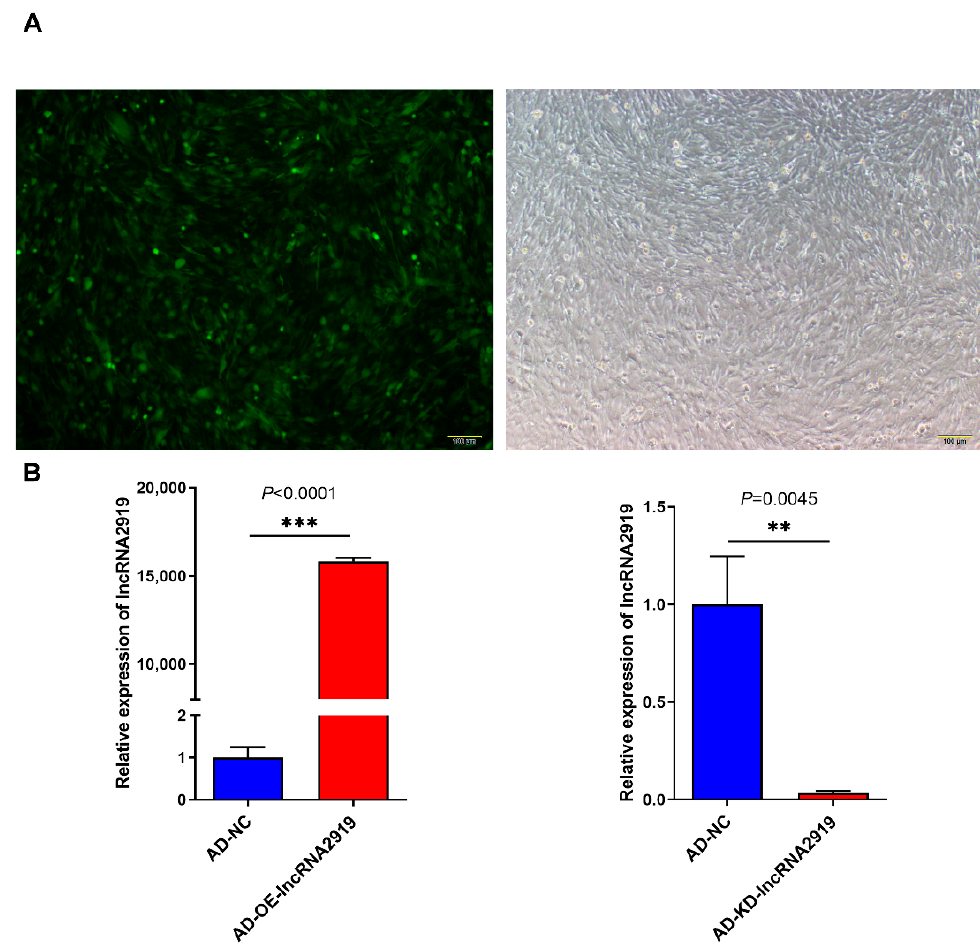
Figure 1. Infection of AD-lncRNA2919 in DPCs. ( A ) Efficiency of infection of AD-lncRNA2919 in DPCs. Scar bar = 100 μ m. ( B ) The lncRNA2919 expression level in the AD-OE-lncRNA2919 and AD-KD-lncRNA2919 groups. Data are presented as mean ± SEM. The two-tailed paired t -test was used for data analyses. For significance, ** p < 0.01, *** p < 0.001.